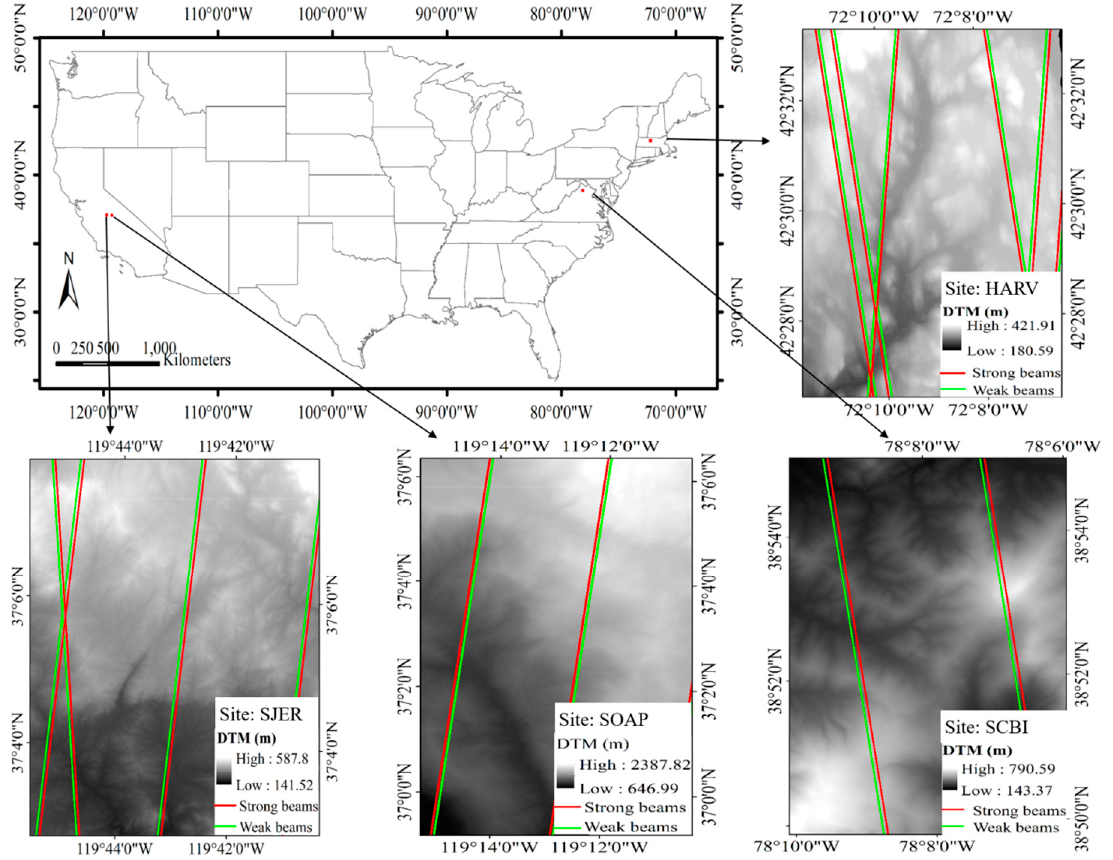
Figure 1. The location of the study area and the distribution of ICESat-2 data.